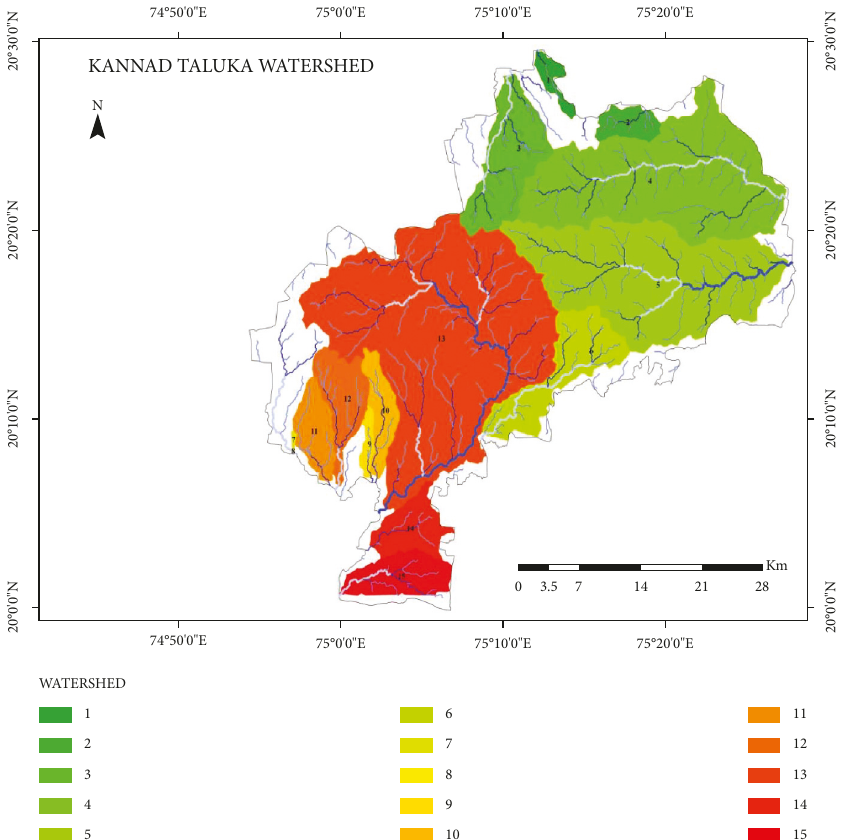
Figure 12: Map of the watershed of Kannad